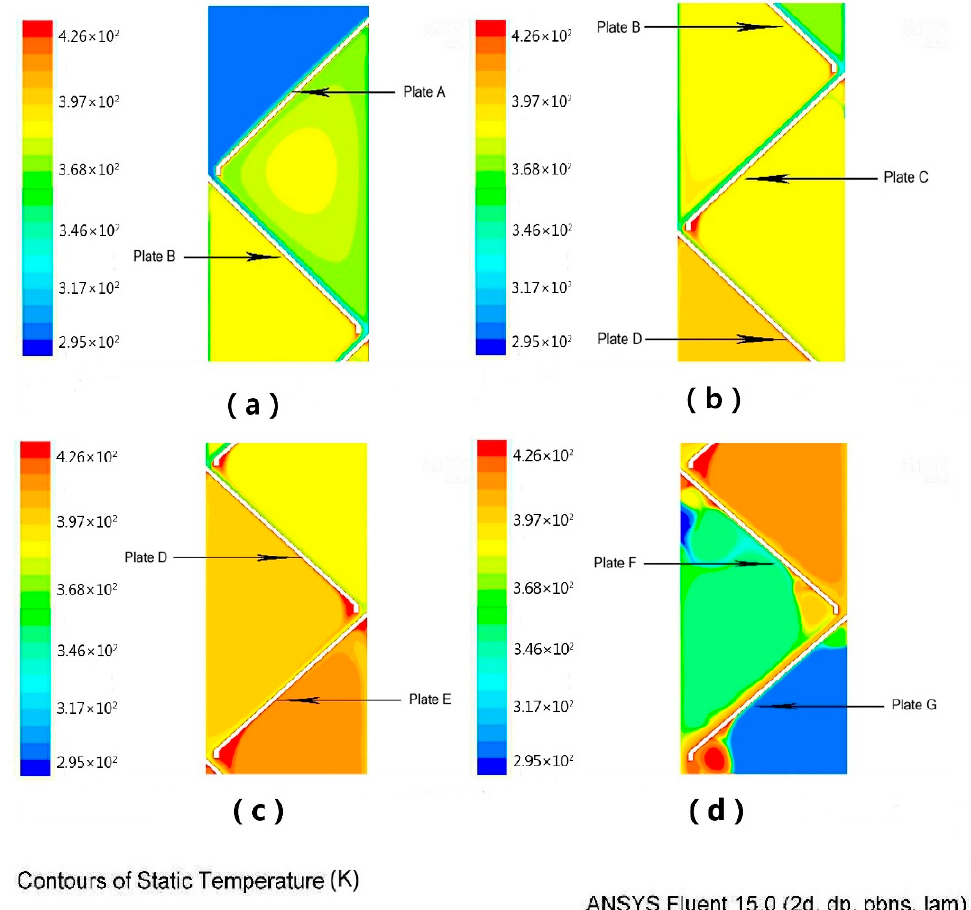
Figure 12. Partial enlarging internal temperature cloud of the new moving bed coal moisture control device: ( a ) internal temperature cloud from Plate A to Plate B; ( b ) internal temperature cloud from Plate B to Plate D; ( c ) internal temperature cloud from Plate D to Plate E; ( d ) internal temperature cloud from Plate F to Plate G.